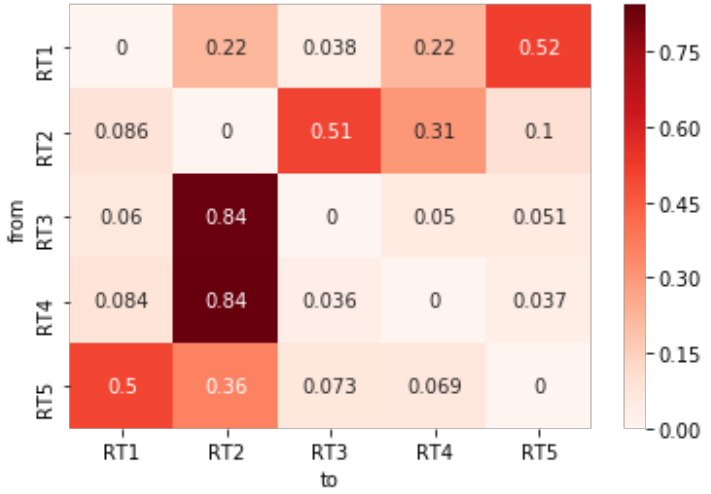
Figure 6. Weighted adjacency matrix of the community-induced directed RT network, normalised by row.